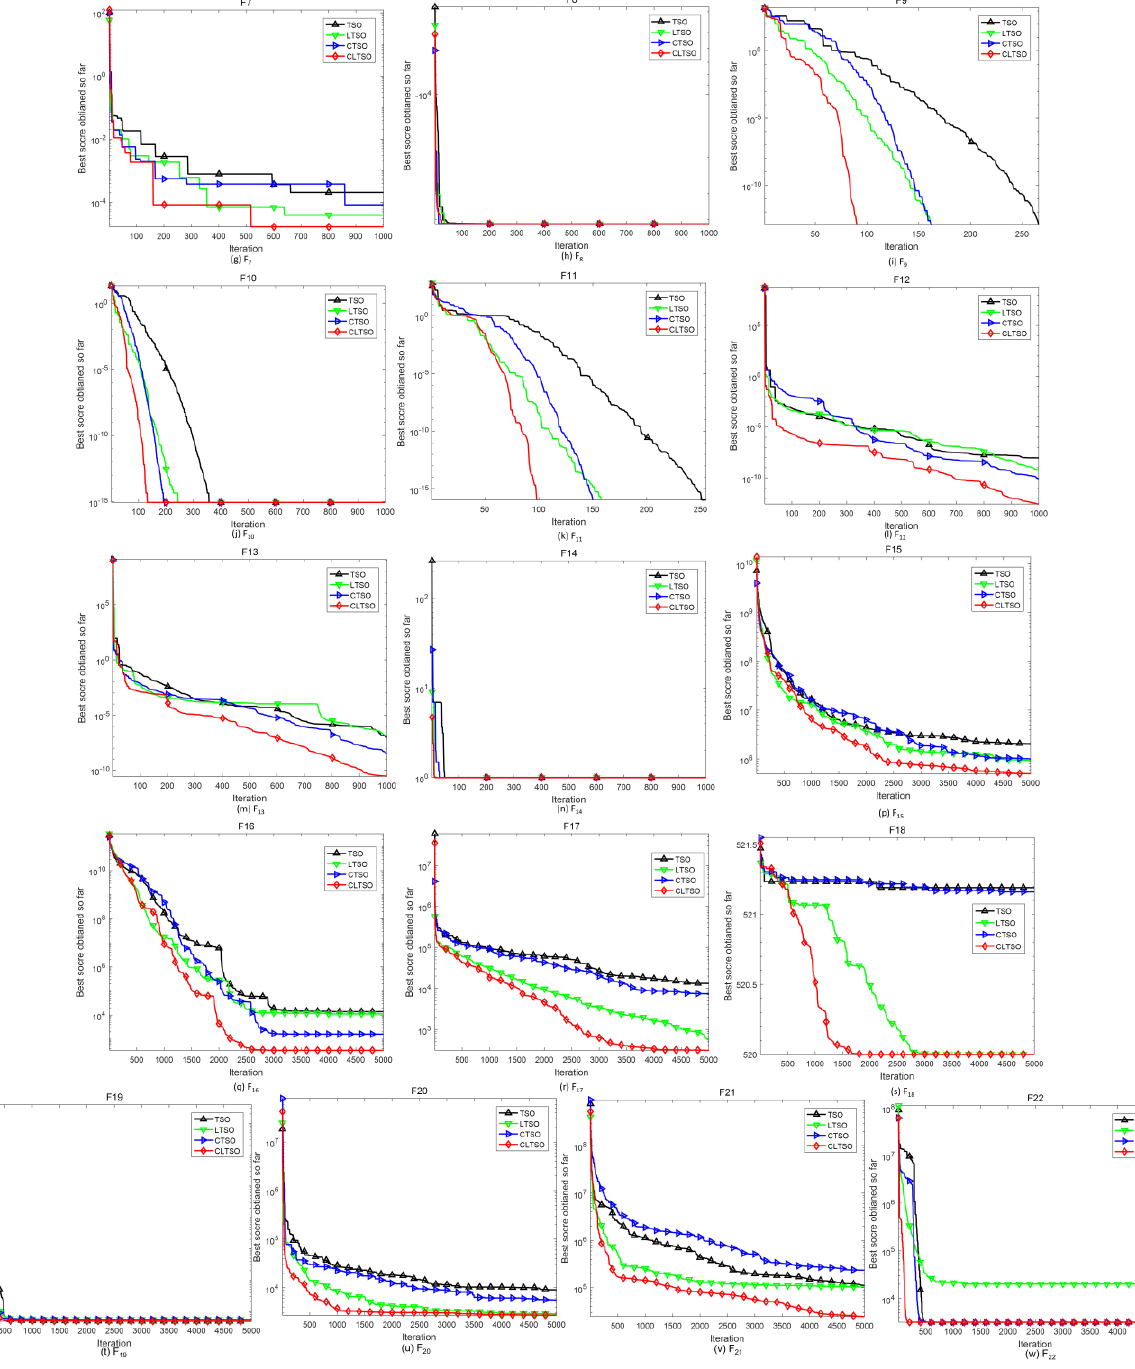
Figure 8. Convergence curves of each version of improved TSO.